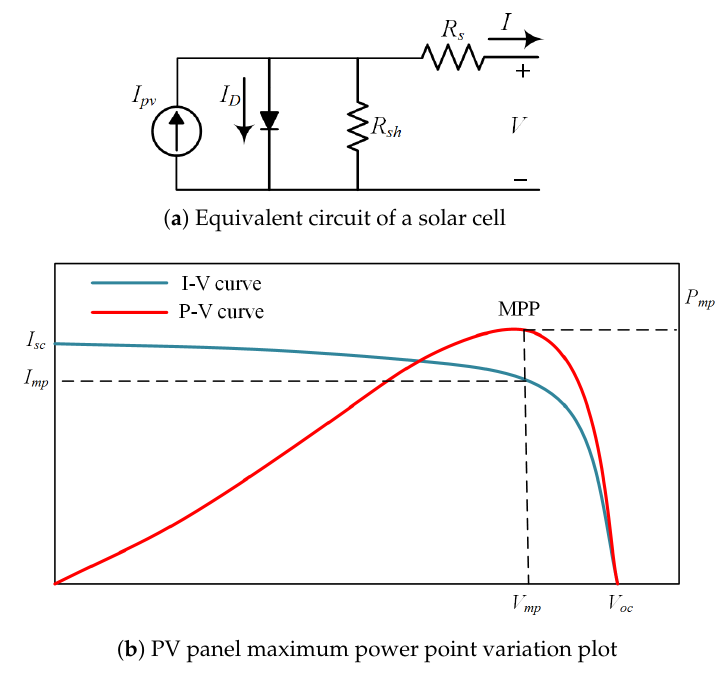
Figure 4. Modeling and analysis of PV